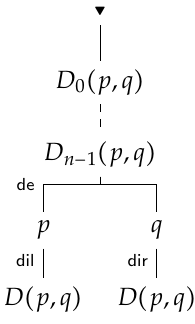
Figure 13. Proof of Proposition